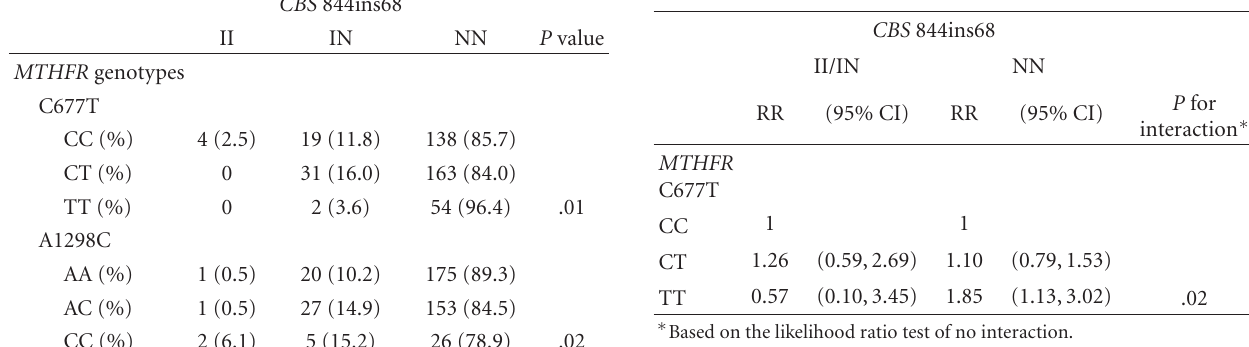
Table 5: Relative risk of CTRD for maternal MTHFR C677T/ CBS 844ins68 genotype combinations estimated by log-linear